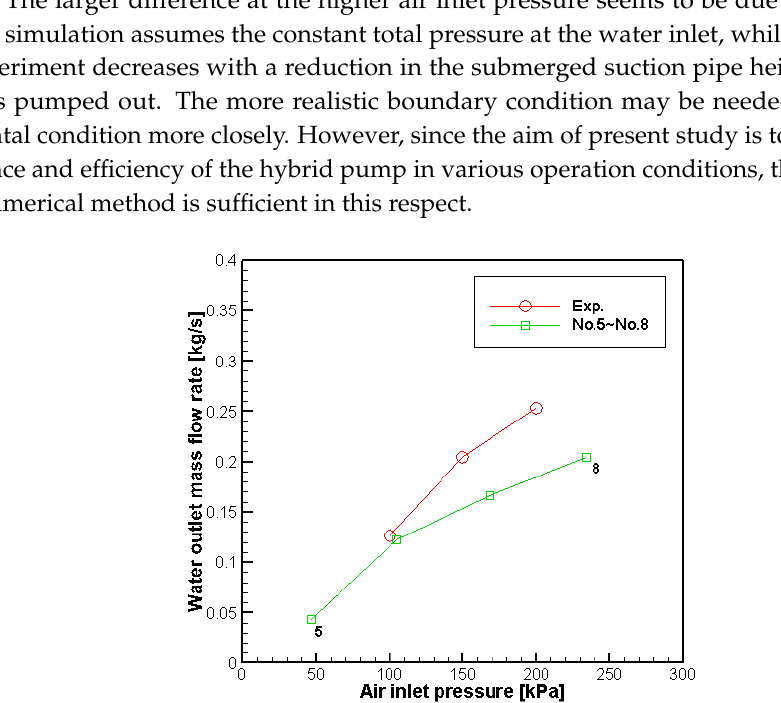
Figure 8. Comparison of predicted water flow rate with measured data according to air inlet pressure.